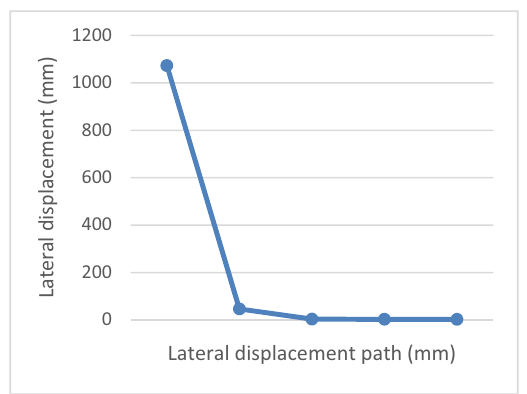
Figure 24: Lateral displacement variation.